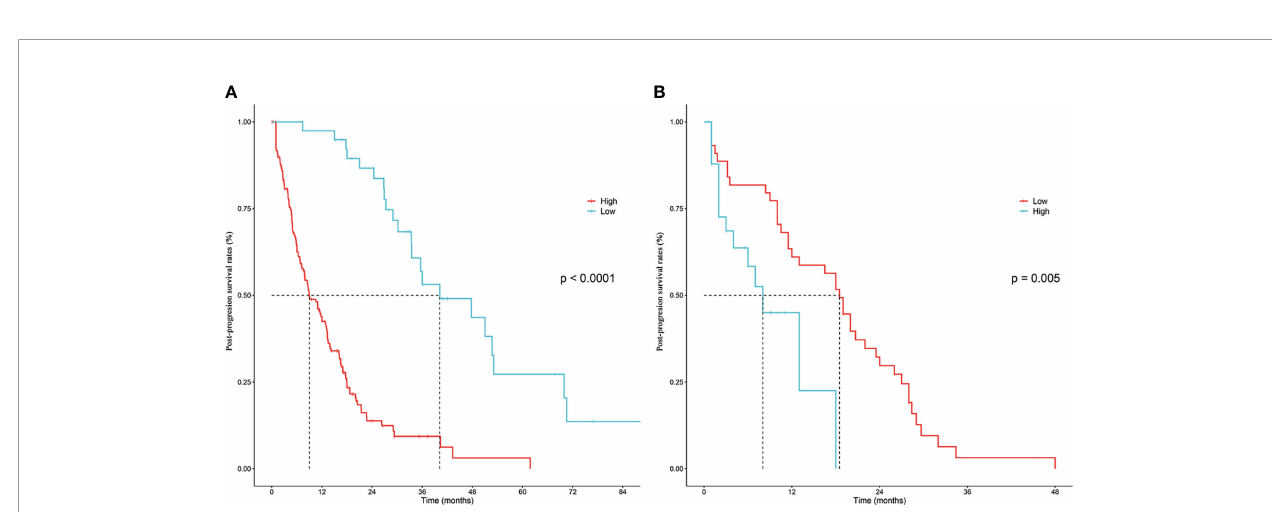
FIGURE 6 | Kaplan – Meier post-progression survival strati fi ed by the nomogram score in the training cohort (A) and validation cohort (B) ,